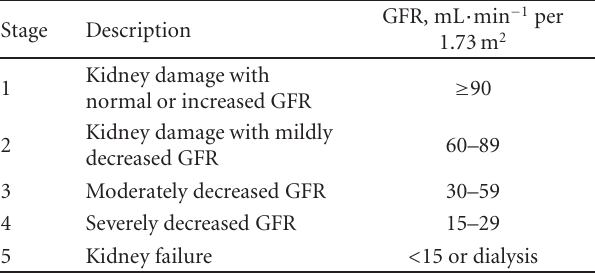
Table 1: Stages of